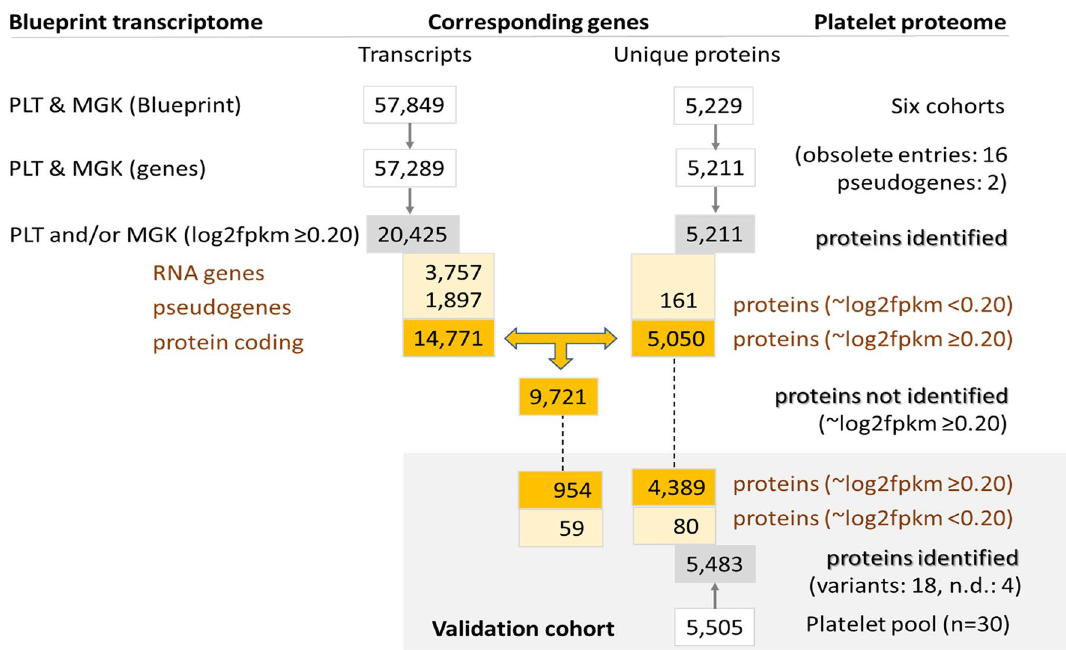
Figure 2. Dataflow of numbers of transcripts of proteome proteins. Relevant transcripts were defined as those of log2fpkm ≥ 0.20. Identified proteins refer to proteins present in the combined proteome from six cohorts. Non-identified proteins refer to proteins with relevant transcript levels in the combined PLT and MGK transcriptome. Data from validation cohort are also indicated.